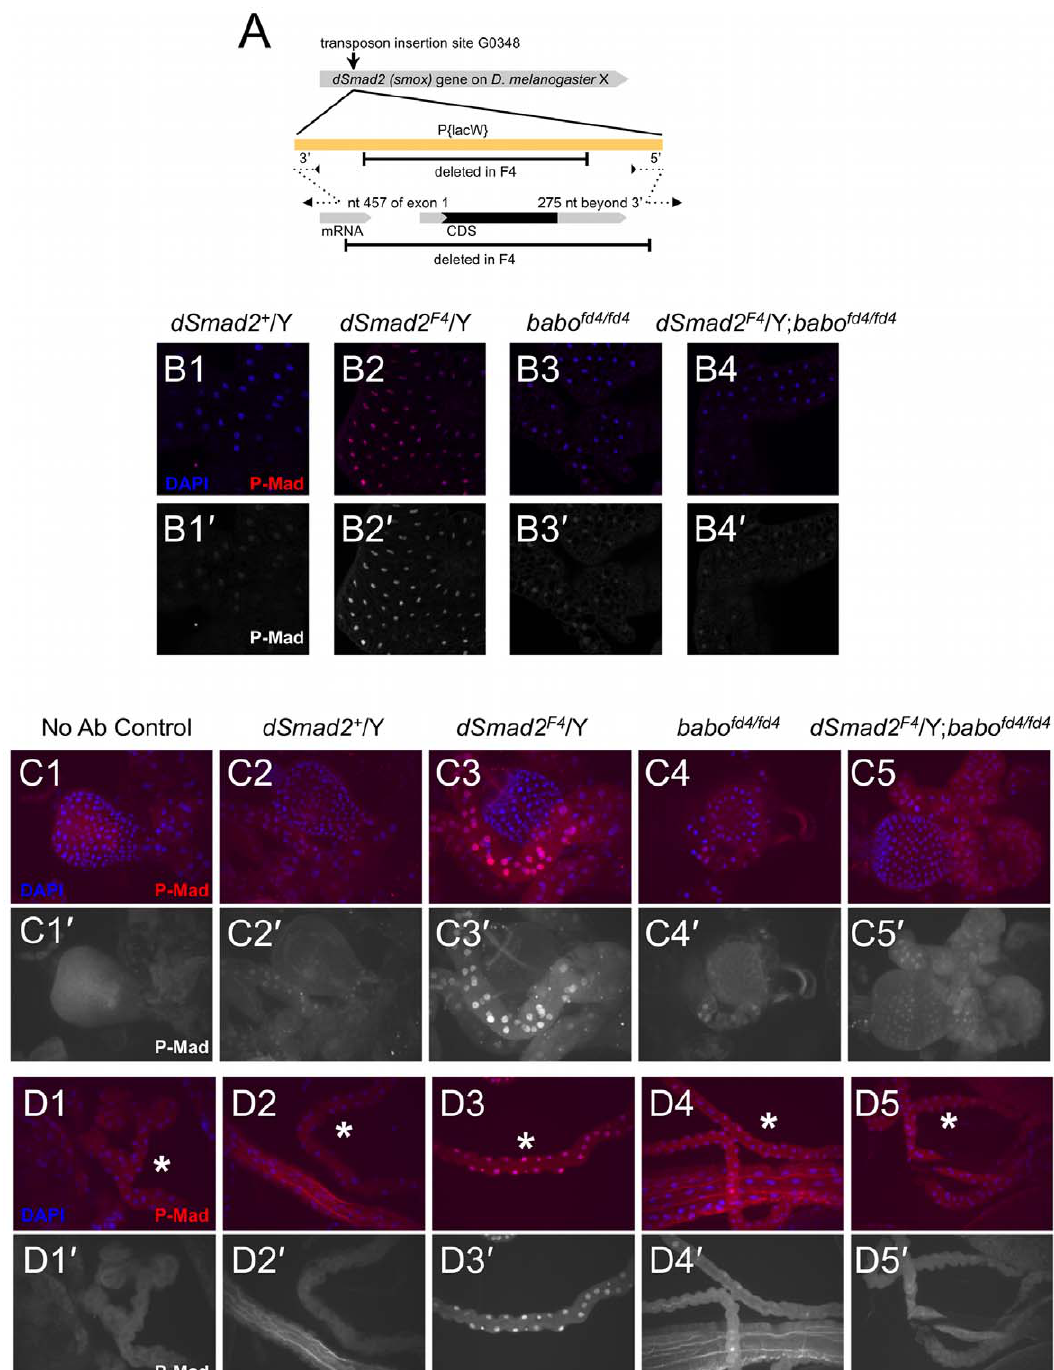
Figure 5. P-Mad elevation in dSmad2 null mutant tissues depends on baboon . The schematic depicts the location of the l(X)G0348 P element insertion in relation to the dSmad2 locus (A). The F4 excision product removed the entire coding region of dSmad2 and portions of the P -element. The genomic breakpoints are indicated above the dSmad2 mRNA; they were determined by sequencing PCR products, indicated by dotted lines. (B–D) P- Mad was detected by IHC of fixed larval tissues from several genotypes. For each image, a merged DAPI (blue) and P-Mad (red) panel is displayed above the isolated P-Mad channel. (B) Single confocal sections of P-Mad staining in the fat body. Under the staining conditions employed, endogenous nuclear P-Mad in a control fat body was barely detected (B1), but was increased in a dSmad2 null mutant animal (B2). Baboon single mutants and dSmad2 ; baboon double mutants had normal P-Mad staining (B3,4). (C, D) P-Mad staining at two representative positions along the digestive tract. Images are Maximal Intensity Projections of 3 micron interval confocal sections through the entire sample. The P-Mad primary antibody was omitted from ‘‘No Ab Control’’ samples to convey any background staining and auto-fluorescence in the red channel. (C) In the gastric caeca near the proventriculus, dSmad2 mutants showed elevated P-Mad (C3) compared to wildtype control males (C2). baboon single mutants and dSmad2 ; baboon double mutants showed wildtype levels (C4 and C5). Distal Malpighian tubule staining (lumpy tubes marked with asterisks) showed the same pattern, with the dSmad2 mutant displaying the strongest P-Mad staining (D3 compared to D2, D4 and D5).